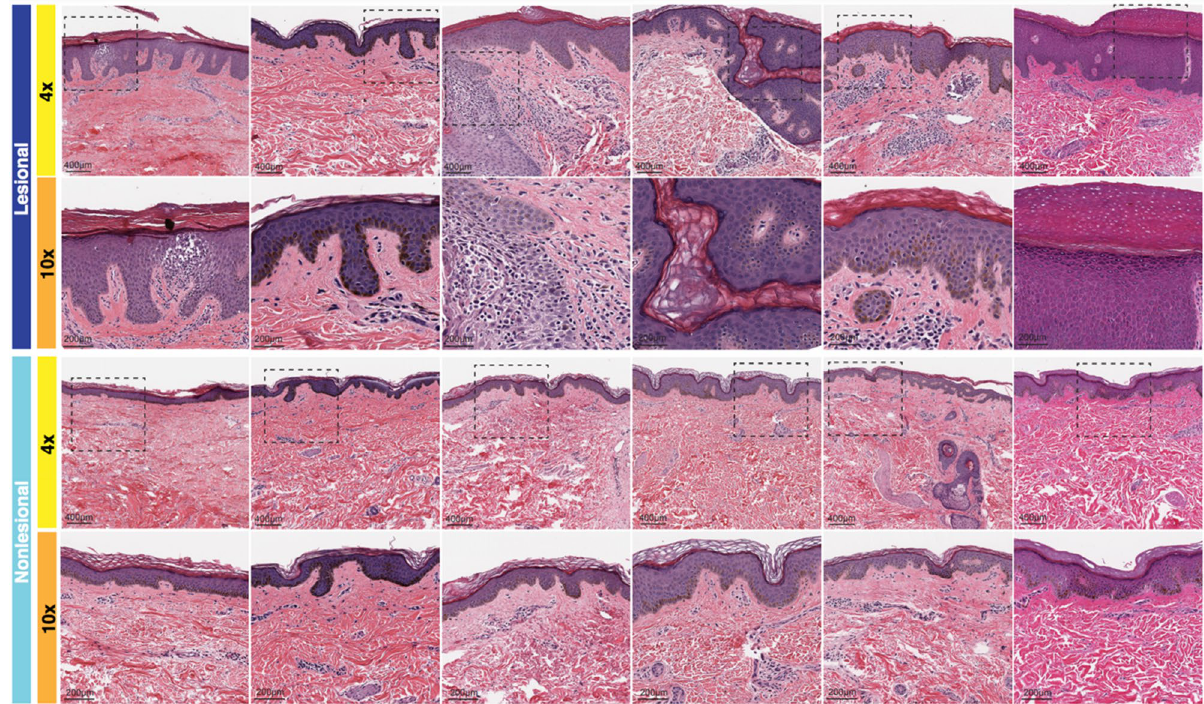
Figure 1. H&E of AD lesional and non-lesional skin. Magnification at × 4 and × 10 demonstrating psoriasiform and spongiotic dermatitis in lesional